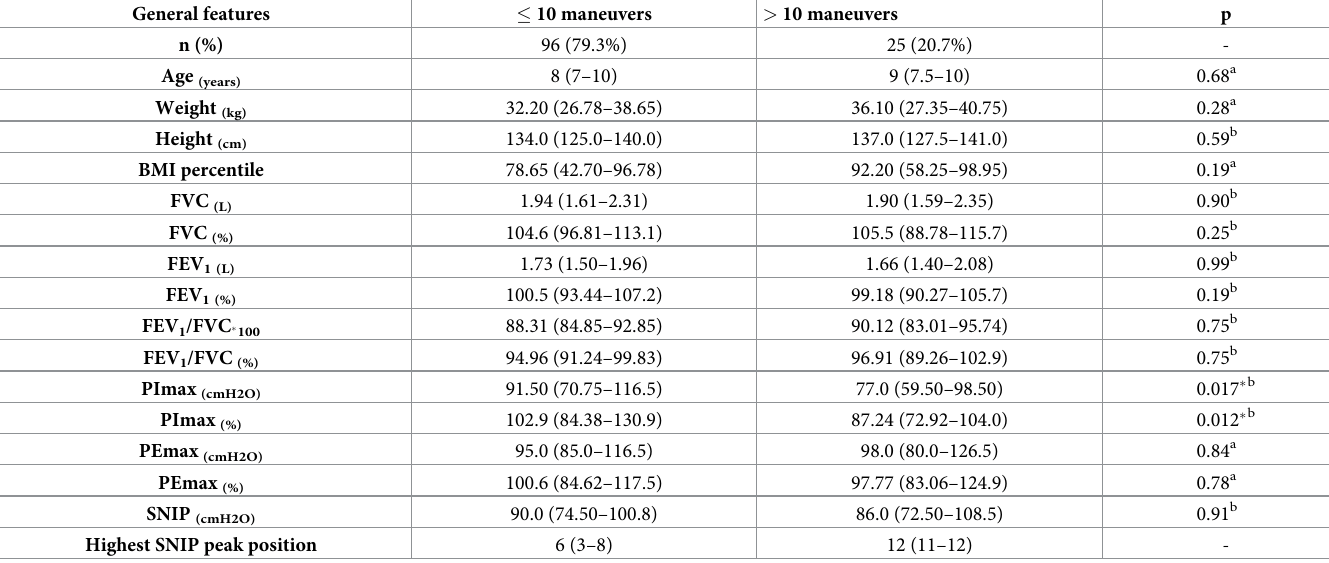
Table 3. Comparisons of general characteristics among children who achieved the highest SNIP until the 10 th and after the 10 th maneuver. General